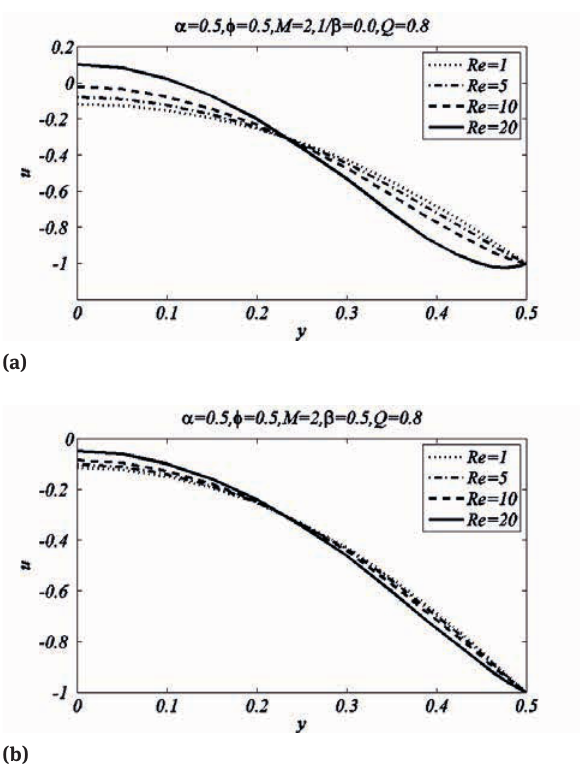
Fig. 7: Comparison of longitudinal velocity for different values of Re (a) Newtonian (b) Non-Newtonian fluid.